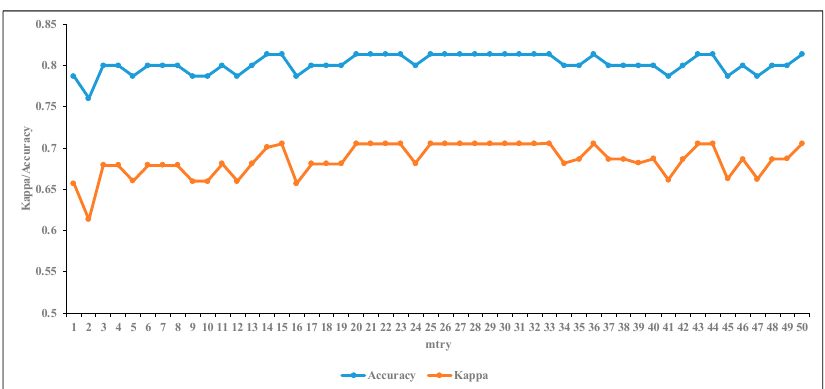
Figure 7. Impact of the number of variables attempted at each node (mtry) on RF classification Figure 7. Impactofthenumberofvariablesattemptedateachnode(mtry)onRFclassificationperformance. performance.